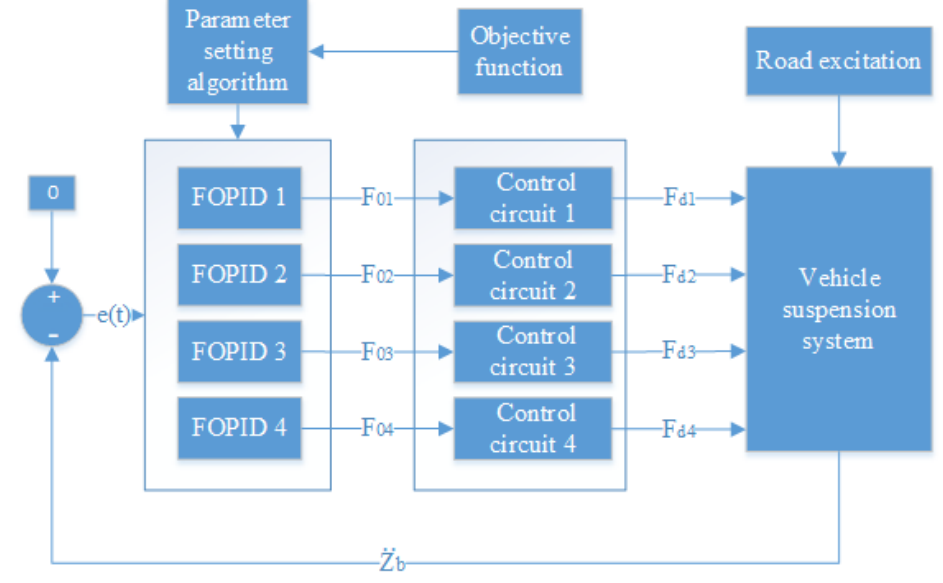
Figure 11. Results of current control experiment.